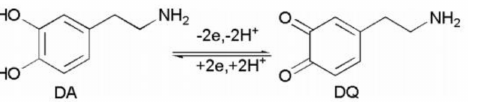
Figure 7. Electro-oxidation process of dopamine. Redrawn from Reference [30].